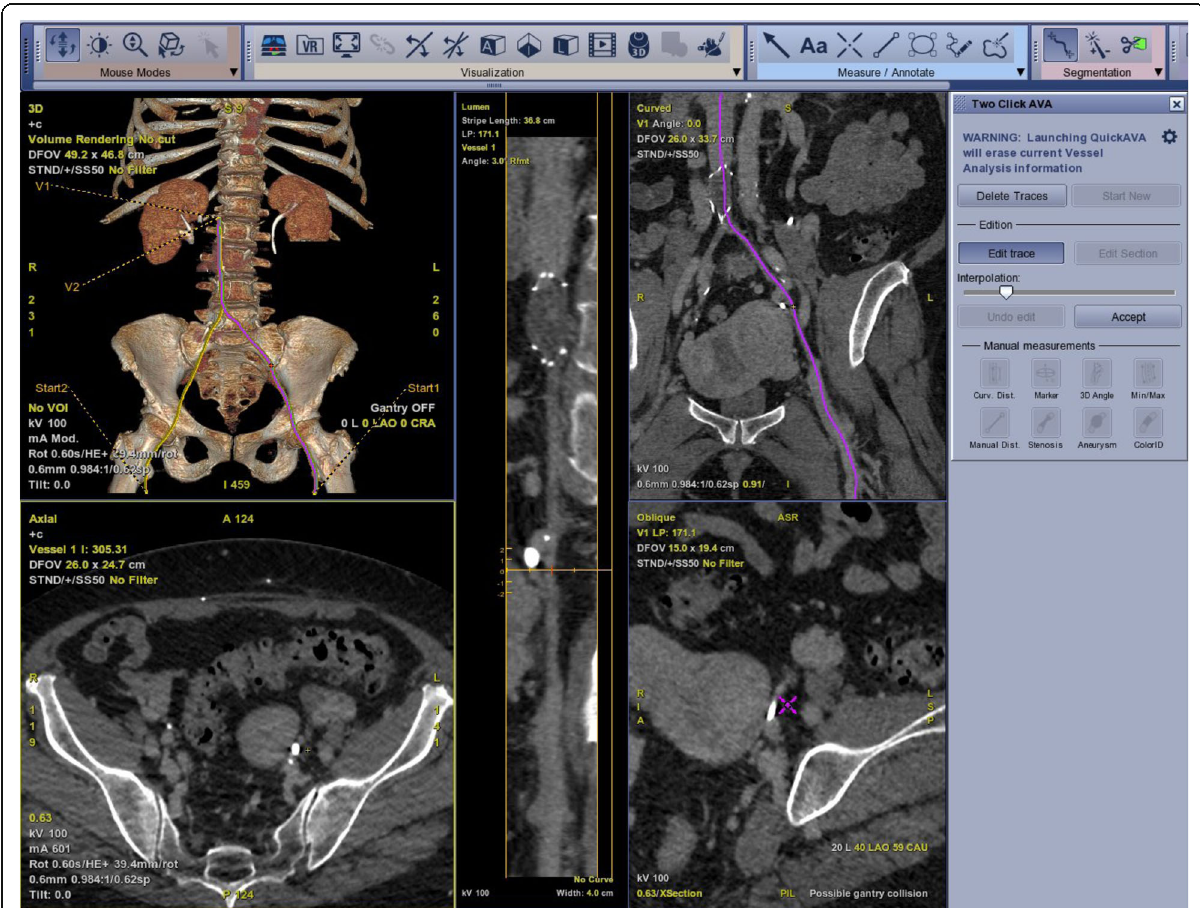
Fig. 2 Screen grab from technologist ’ s monitor during center line creation from pre-procedural imaging on a patient with bilateral ilio-femoral occlusions. The centerlines are defined on each side from a point distal to the occlusion and proximal to the patent portion of the inferior vena